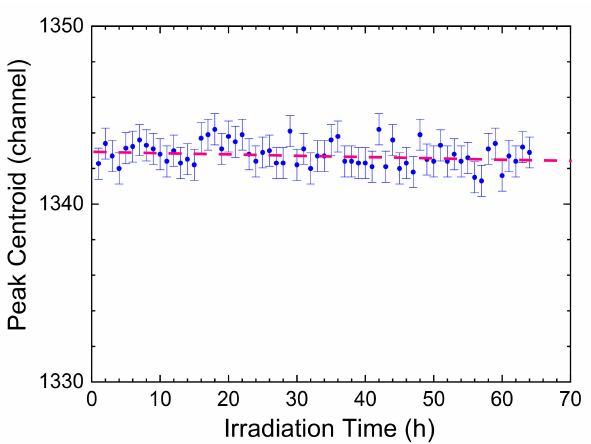
Figure 26. Measured time stability of the peak centroid of the 12 C(n, α 0 ) 9 Be reaction induced by 18 MeV neutrons at the Van der Graaf accelerator of the JRC-Geel (Belgium). Result obtained by irradiating continuously for more than 60 h for a 500 µ m thick diamond